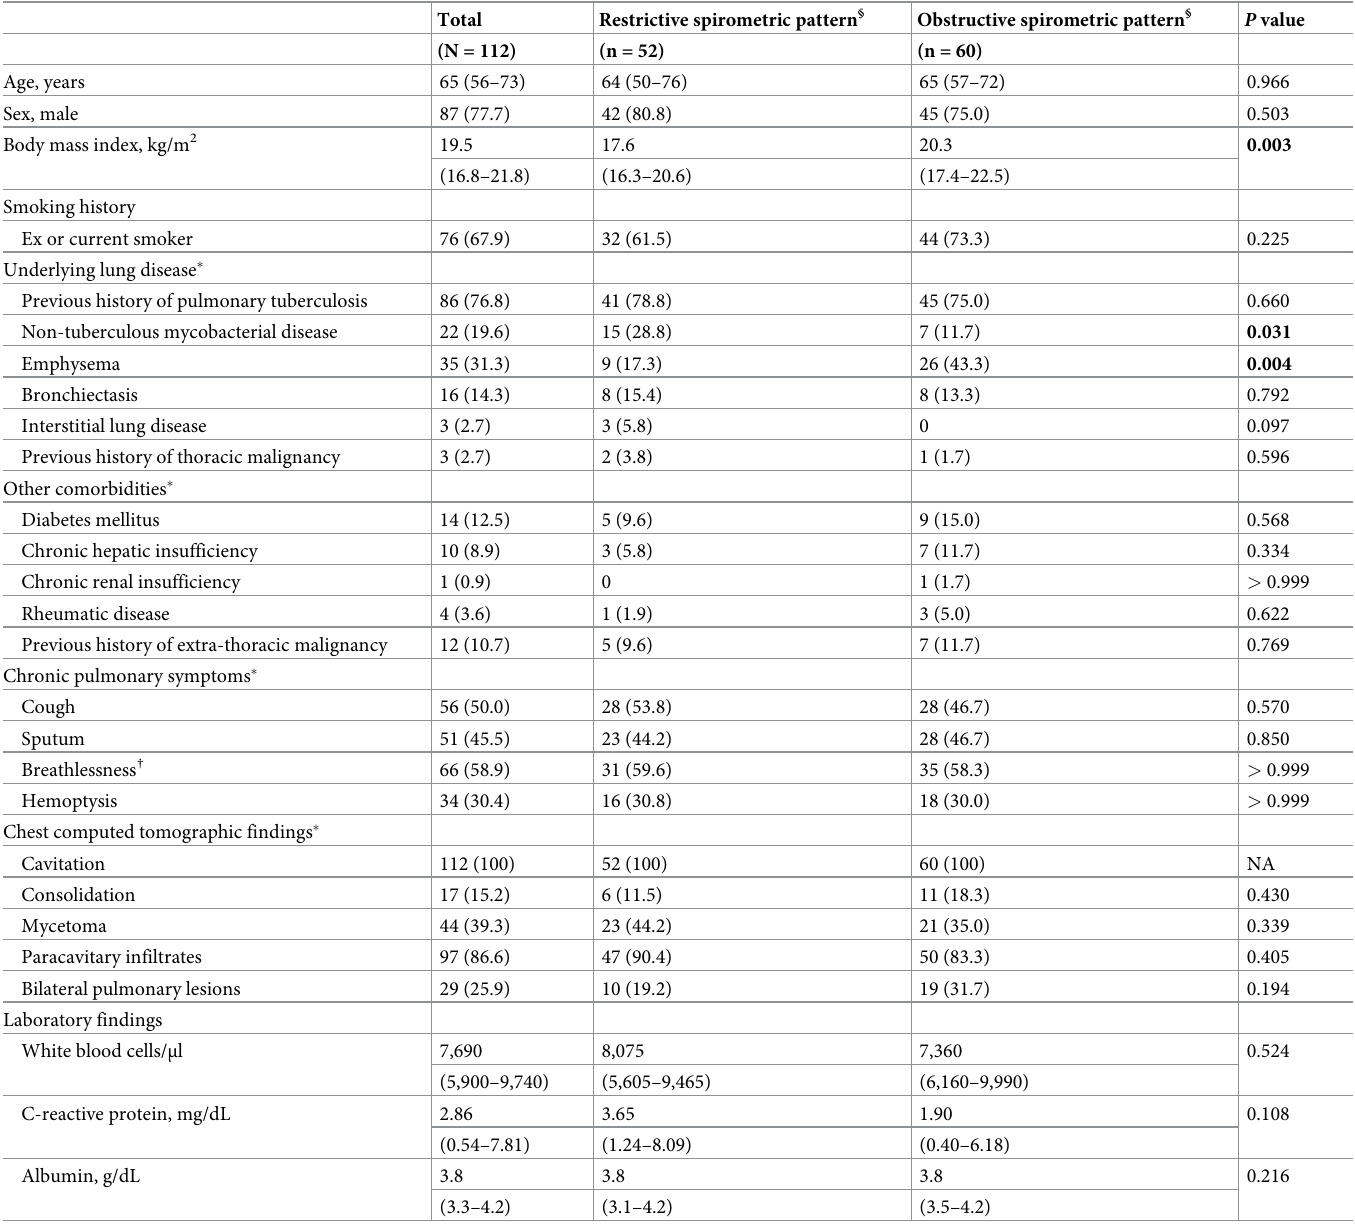
Table 1. Patient characteristics according to spirometric patterns §